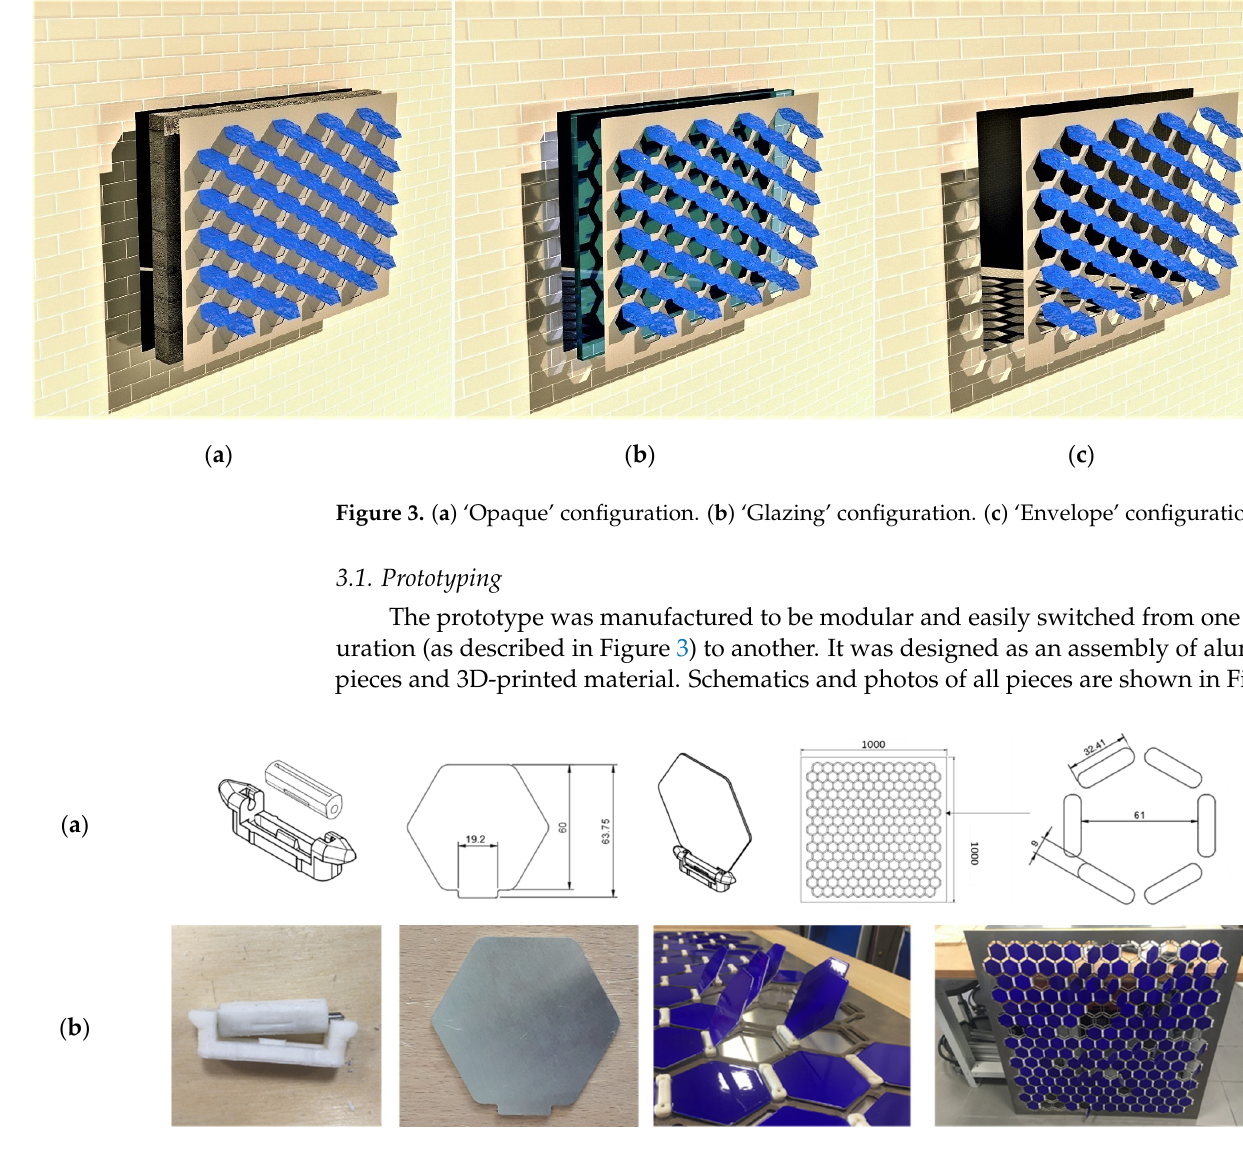
Figure 4. ( a ) Schematics of the notched system, flaps, and the aluminum frame. ( b ) Photographs of the prototype elements.